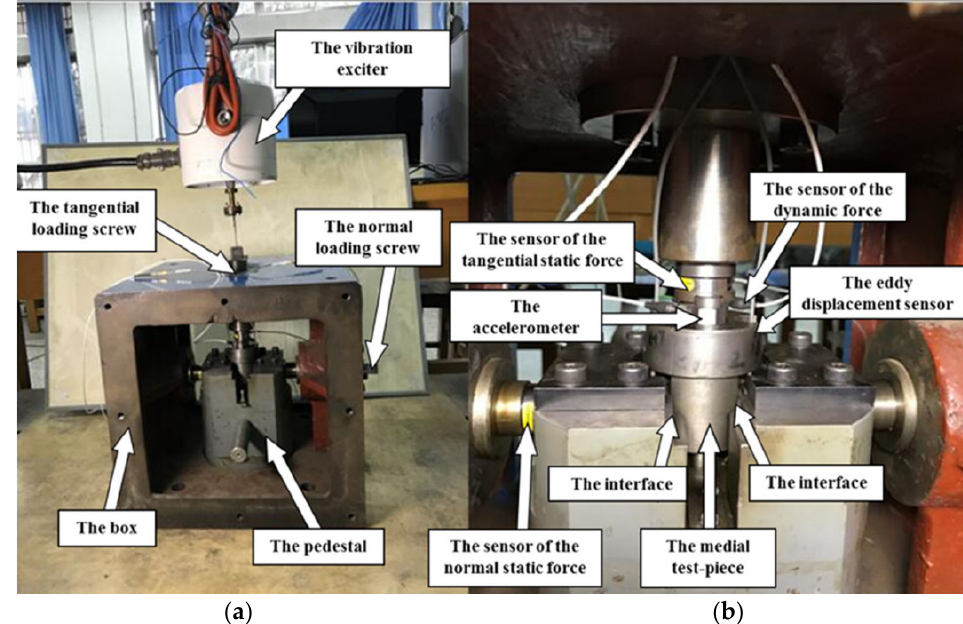
Figure 11. Experimental device of the tangential contact stiffness and damping.( a ) Experimental box. ( b ) The layout of sensors.